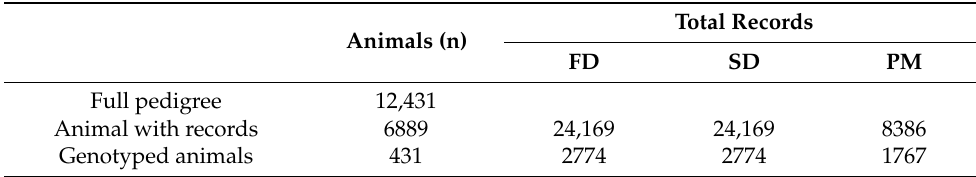
Table 1. Number of records of the fiber diameter (FD), standard deviation (SD) and percentage of medullation (PM) and pedigree records in the